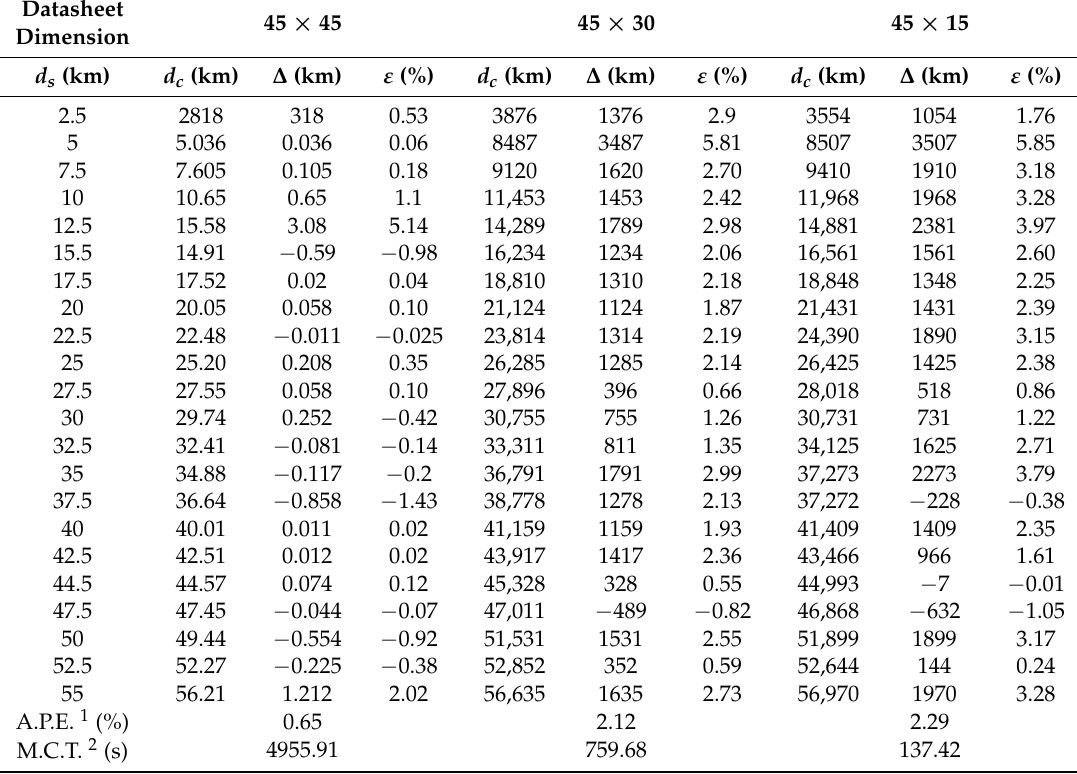
Double-circuit OHL: Fault Location Errors for ANN-based Algorithm for Different Datasheet